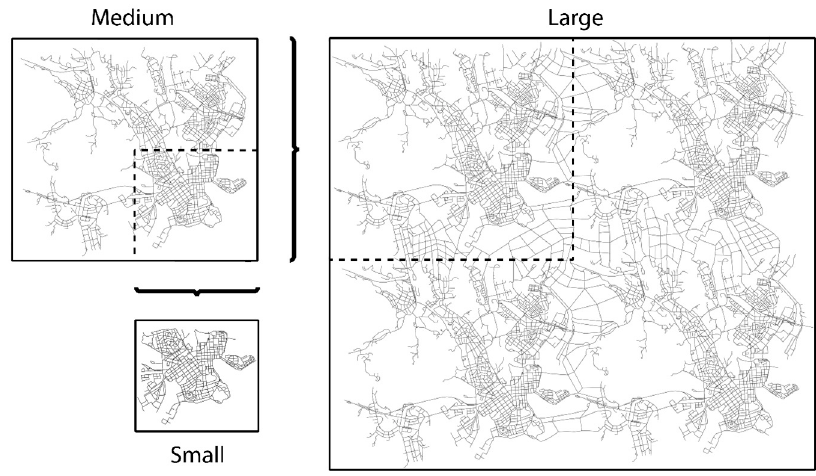
Figure 7. Movement scenarios (namely small, medium and large) used for evaluating the impact of increasing network size on the amount of contact information maintained by PRoPHET and PoiFord.